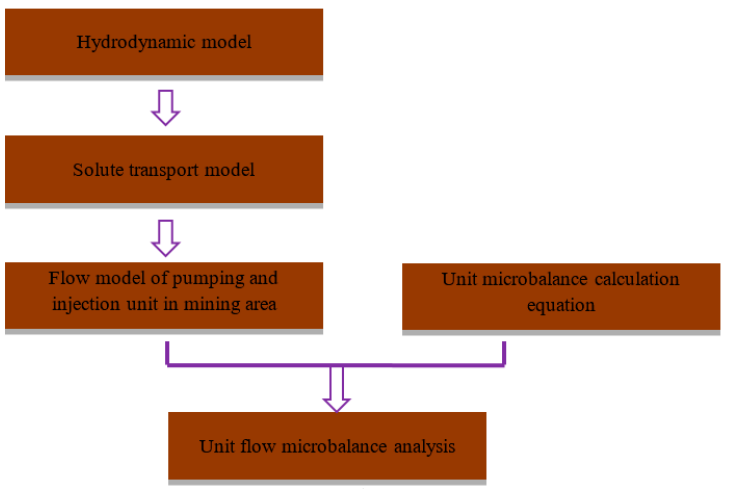
Figure 2. Flow chart of micro-balance calculation for flow rate of pumping and injection unit in mining area.